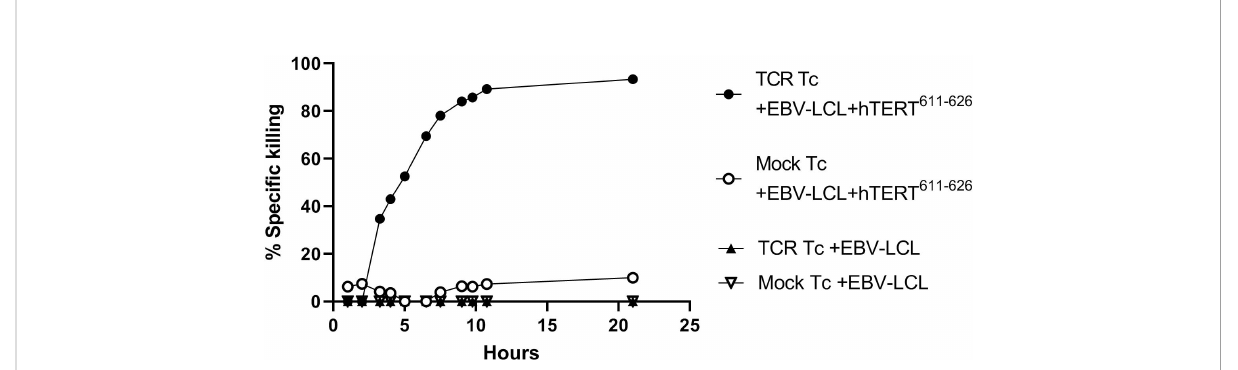
FIGURE 6 TCR induced killing of hTERT-peptide presenting target cells. TCR-transfected and mock-transfected T cells were tested using a luciferase expressing HLA-matched Epstein Barr virus (EBV) transformed lymphoblastoid cell line (EBV-LCL). The cells were loaded with the corresponding peptide hTERT 611-626 . Effector:target (E:T) ratio was 30:1 and luminescence was measured with a luminometer at de fi ned time points. All conditions were tested in triplicates and after 2 months of therapeutic cell storage. This will be done prior to patient infusion in the T-RAD study and a threshold of ≥ 60% speci fi c killing at 10hrs used for a functional